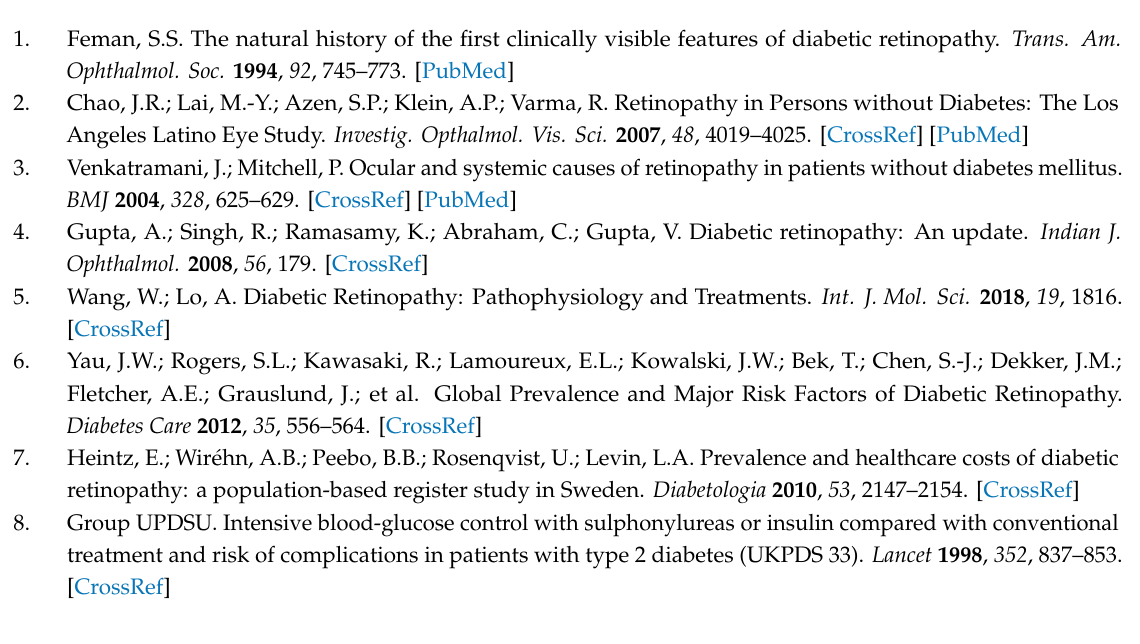
Table S1: Examination, demographic, and laboratory variables excluded from the study due to having zero variance, Table S2: Statistically significant principal components (PCs) associated with diabetic retinopathy (DR), Table S3: RandomForest ™ -selected features for replication cohort NHANES 2005–2006, Figure S1: Laboratory variables statistically significantly associated with diabetic retinopathy, Figure S2: Inter-correlation among laboratory variables statistically significantly associated with diabetic retinopathy, Figure S3: Principal component analysis (PCA) highlights key sources of variation in the